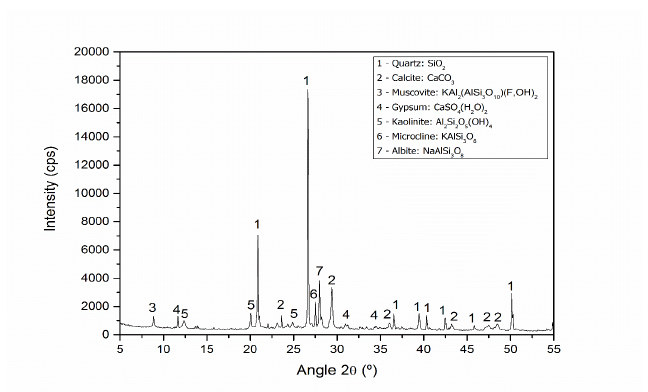
Figure 5. Diffractogram of the recycled aggregate.